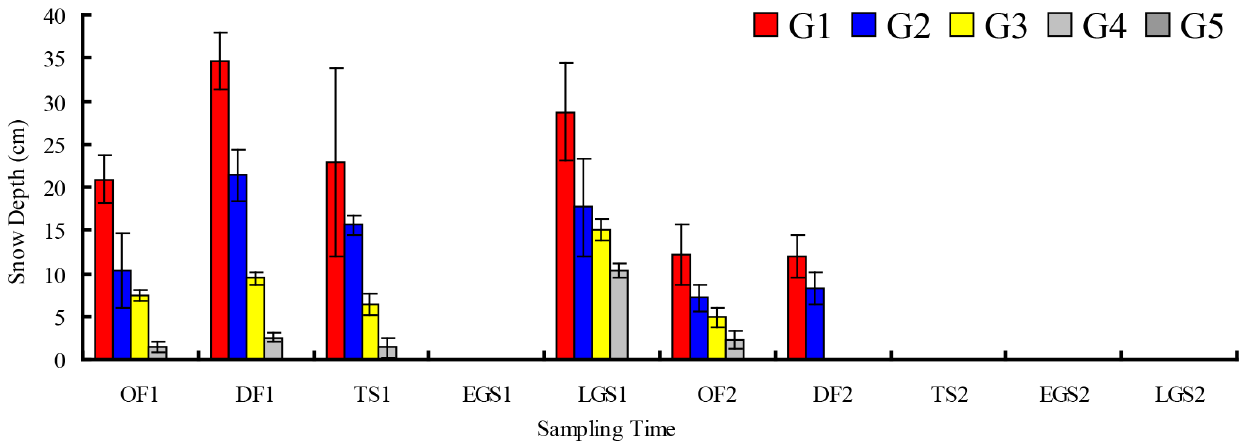
Figure 3. Depth changes of winter snowpack in different sampling time (mean ± SD , n =5). Abbreviations: OF=onset of freezing stage; DF=deep freezing stage; TS=thawing stage; EGS=early growing season; LGS=late growing season; G1=gap 1, gap center south; G2=gap 2, gap center north; G3=gap 3, canopy edge; G4=gap 4, expanded edge; G5=gap 5, closed canopy.